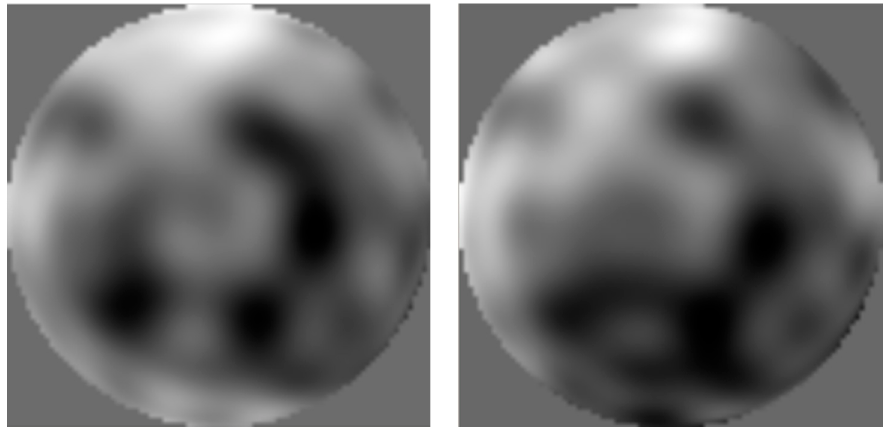
Figure 3. Comparison for r 0 = 8 cm. The residual WFE for this case is 180.85 nm, higher than the mean value obtained over the test. The original phase is placed on the left, with the reconstructed one shown on the right.